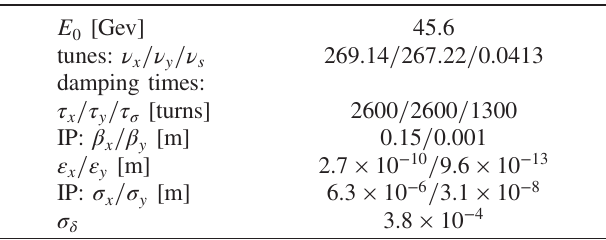
TABLE I. FCC-ee lattice parameters.